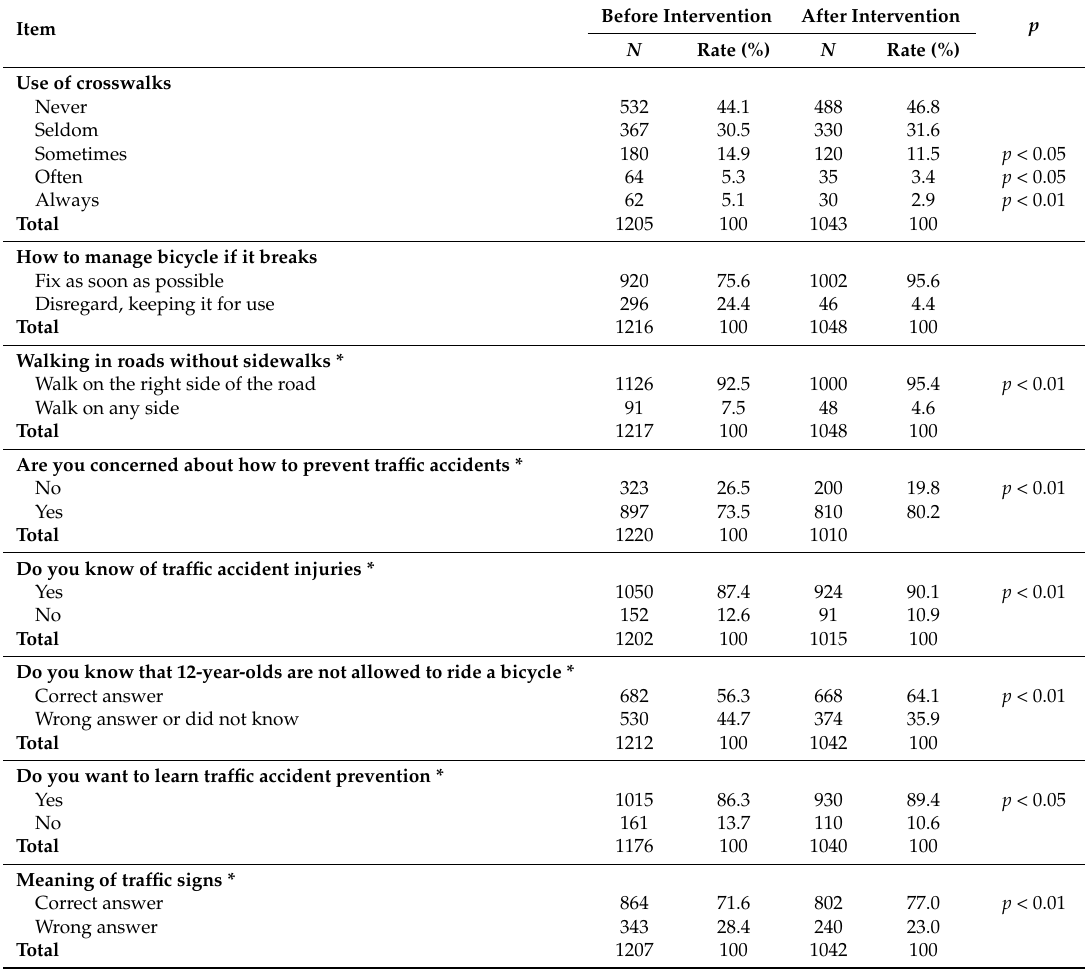
Table 2. The KAPs toward safe biking before and after the intervention among students in the intervention